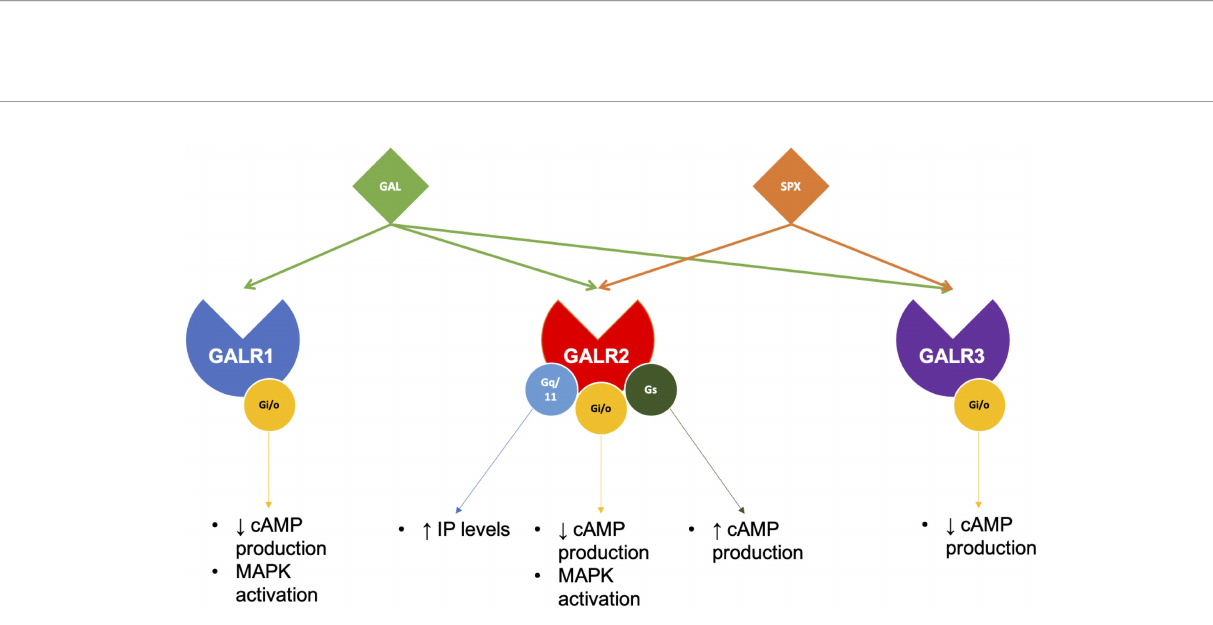
FIGURE 3 | Galanin receptors pair with different G-proteins to execute SPX or GAL functions. In brief, GAL acts on all three of its receptors, while SPX only pairs with GALR2 and GALR3. Although both GALR1 and GALR3 can only pair with Gi/o proteins, GALR2 has been found to pair with several G-proteins, mediating various downstream